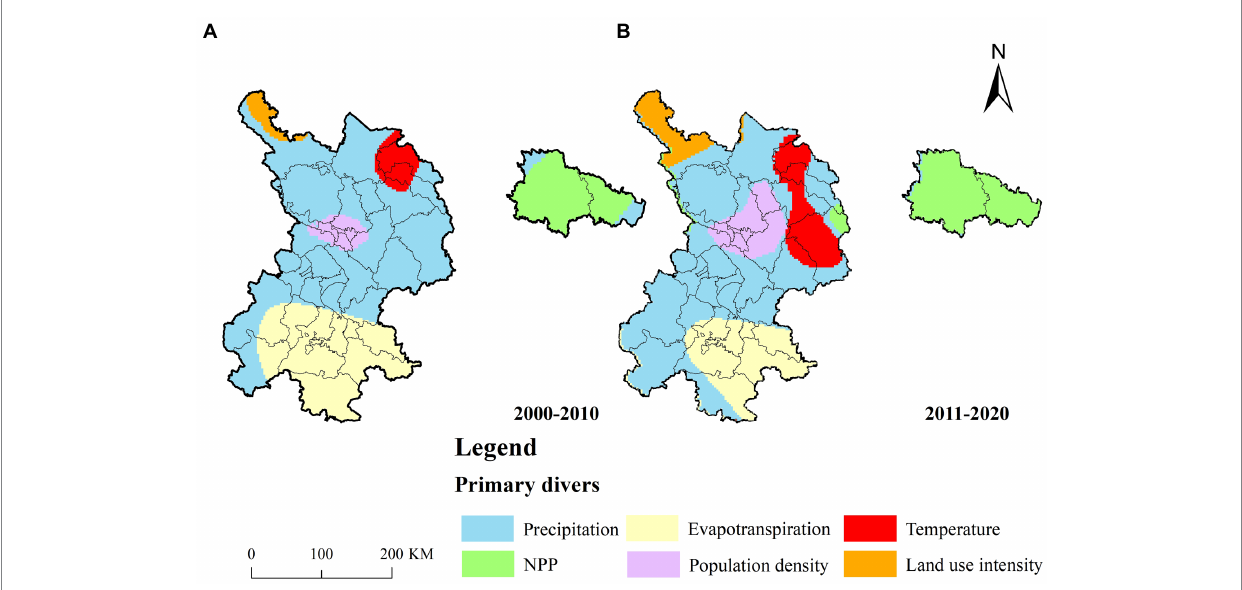
FIGURE 7 Spatially identify the first influencing factor of WYs in each region. Taking 10 years as a stage, the rule changes of each type of influencing factors on WYs were discussed. (A, B) are the spatial distribution of the dominant active factors for WYs in 2000–20010 and 2011–2020,